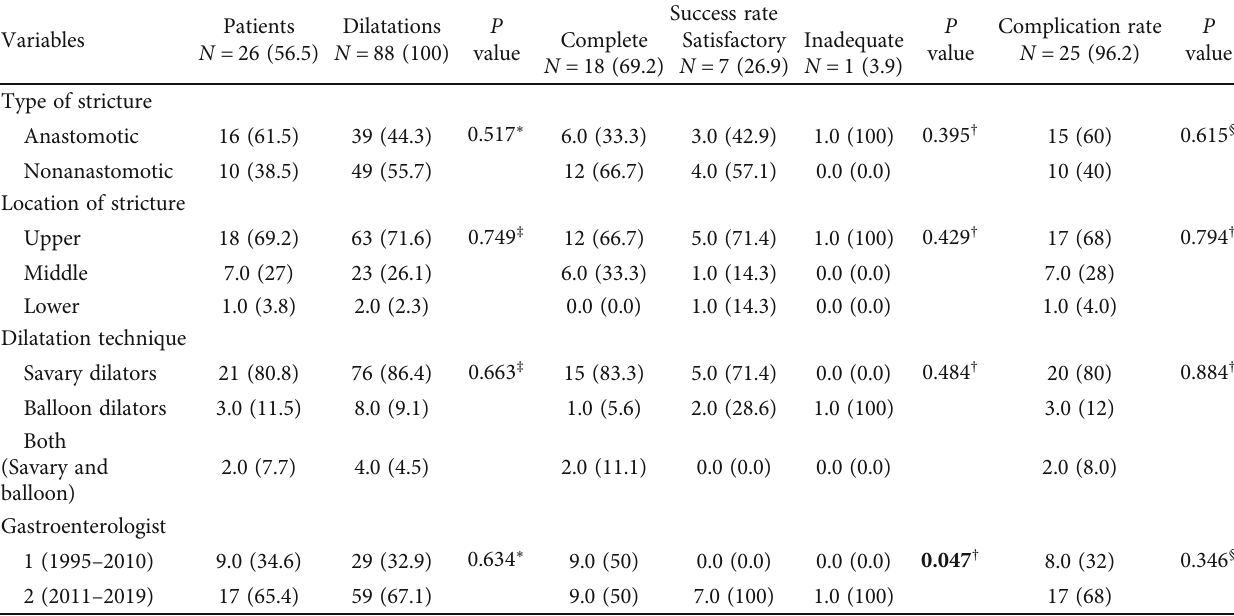
Table 3: Outcome of endoscopic dilatations in children with esophageal strictures in relation to the type and location of stricture, dilatation technique, and gastroenterologist who performed the